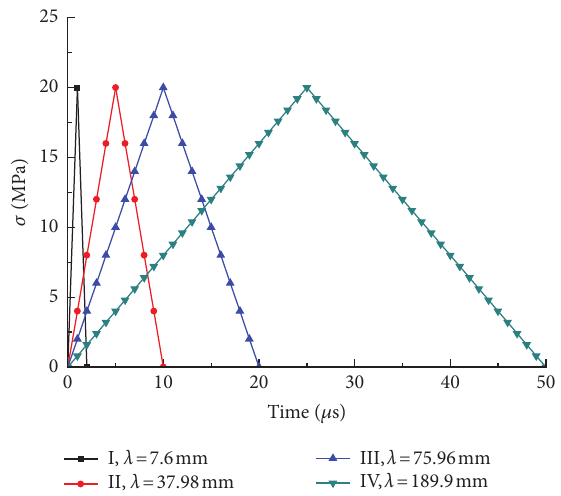
Figure 5: Stress waves applied on the rock